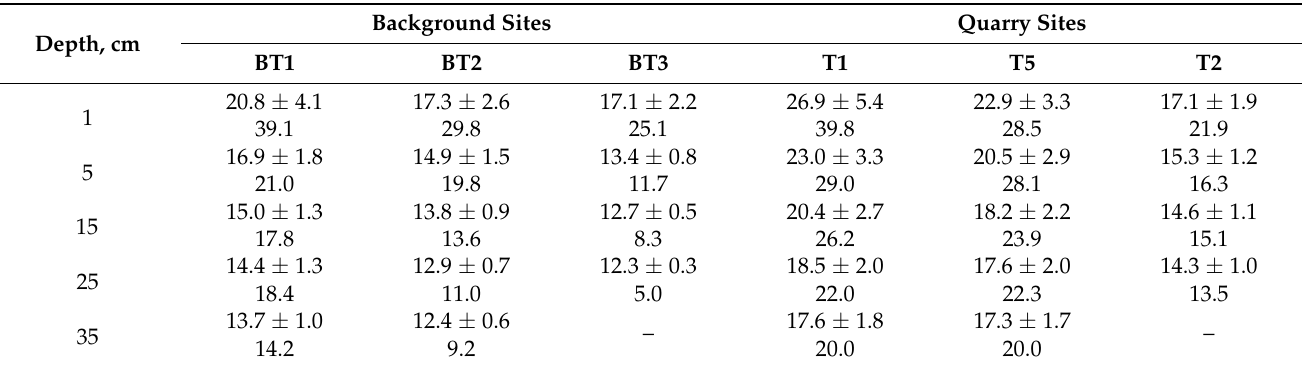
Table 3. Mean summer temperatures ( ◦ C) and their variation coefficients ( % ) in background and quarry